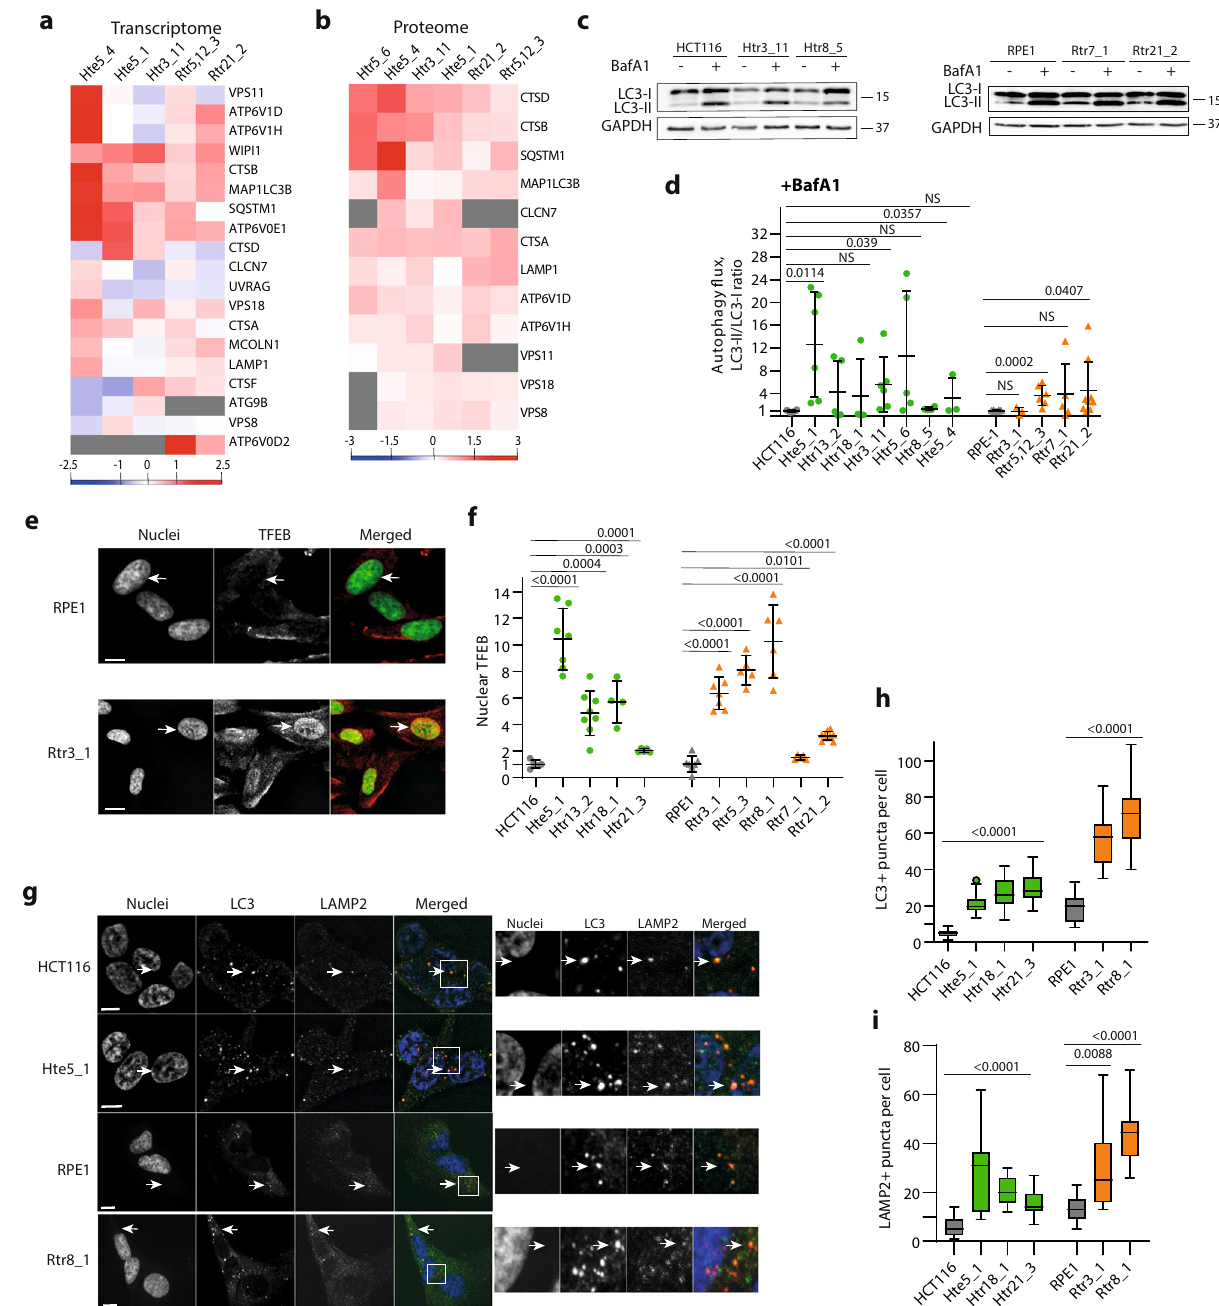
Fig. 1 Autophagy and lysosomal degradation is activated in cells with extra chromosomes. a Transcriptome and b proteome analysis of TFEB targets. The heat maps show fold changes in trisomic and tetrasomic cells compared with parental diploids. c Immunoblotting of LC3; GAPDH serves as a loading control. d Quanti fi cation of the LC3-II/LC3-I ratios upon treatment with Ba fi lomycin A1 (BafA1) and in control DMSO-treated cells. Each point represents one independent biological experiment, 3 – 10 experiments were performed in each cell line. e Localization of TFEB was assessed by immuno fl uorescence analysis. White arrows point to the localization of the nucleus in these cells. f Quanti fi cation of the relative TFEB nuclear localization. The difference in mean fl uorescent intensity (MFI) between nuclear and cytoplasmic signals was calculated and plotted relatively to control diploid cells. At least 2000 cells for HCT116 and 1000 cells for RPE1 cell lines were analyzed in each experiment, the means of each experiment are plotted. Each point represents the mean from one independent biological experiment, 4 – 7 experiments were performed in each cell line. g Immuno fl uorescence images of LC3 and LAMP2 localization in trisomic and diploid cells. White arrows indicate double-positive puncta. h , i Quanti fi cation of LC3- and LAMP2-positive puncta per cell. Number of analyzed cells: n = 30 for LC3, n = 20 for LAMP2 in each cell line. Unpaired t -test was used for statistical analysis, unless otherwise speci fi ed. Individual measurements, mean values, p -values, and standard deviations are shown in the plots, statistical evaluation is summarized in Supplementary table 4, and source data is available in Supplementary Data 5. Scale bar 10 µ m. Mann – Whitney statistical analysis was applied for data in f